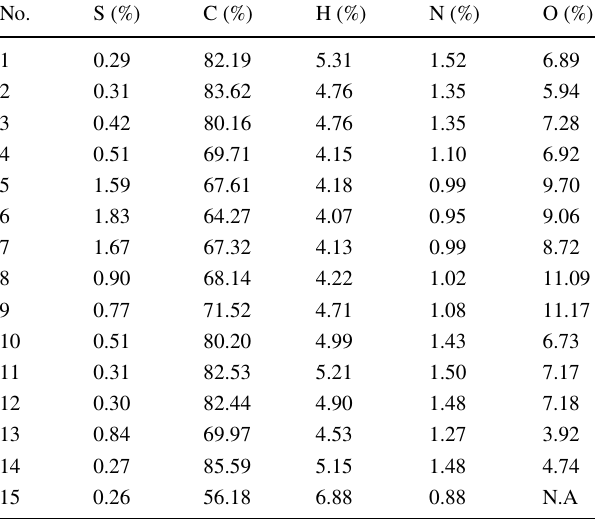
Table 4 Matrix of physical parameters of tested samples No. Parametr Jednostka